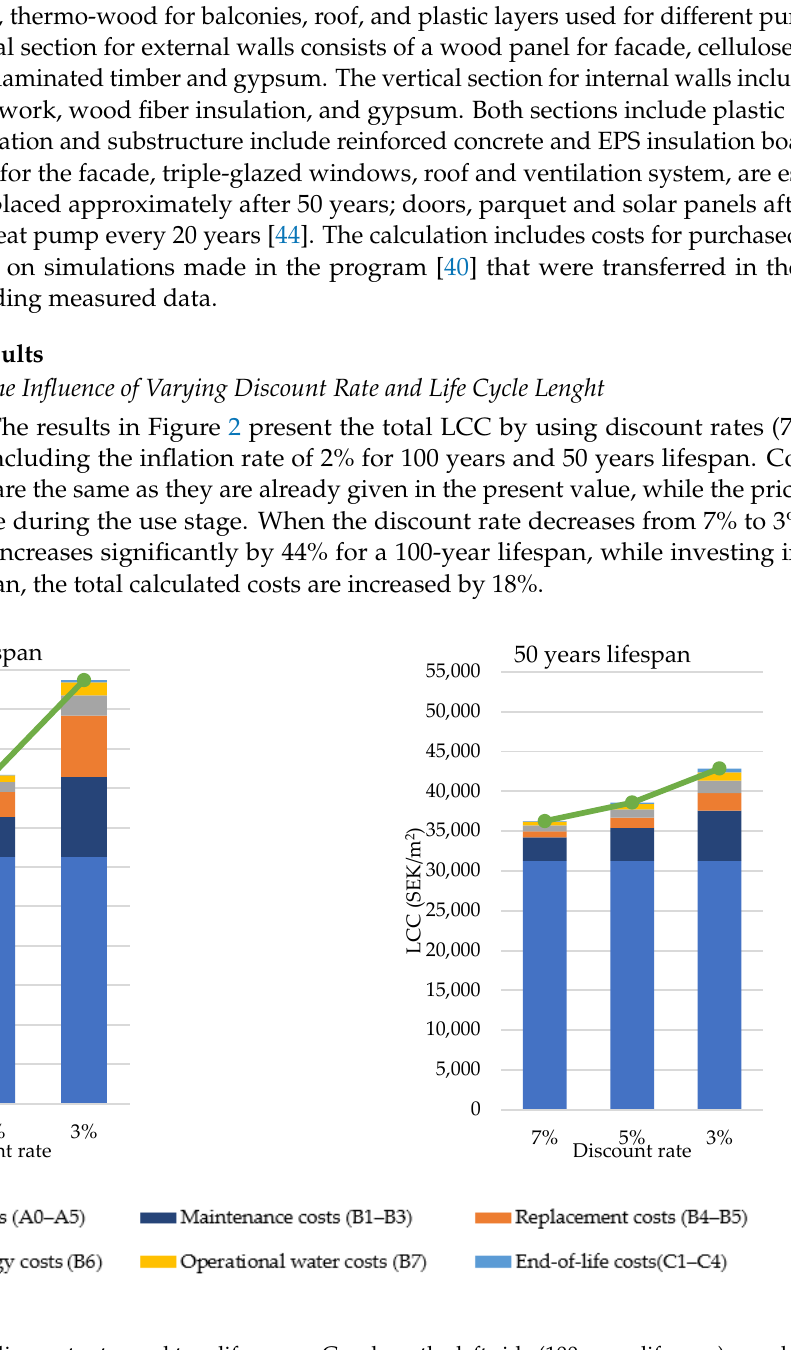
Figure 2. LCC including different discount rates and two life spans. Graph on the left side (100 years lifespan); graph on the right side (50 years lifespan).